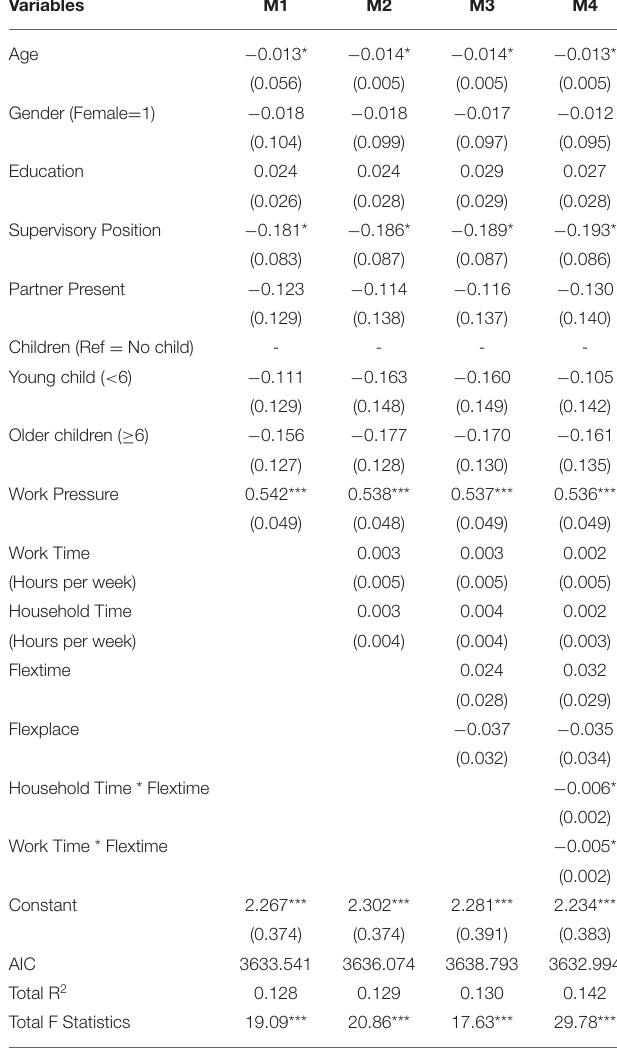
TABLE 1 | Descriptive statistics for variables used ( N = 1,058). TABLE 2 | Unstandardized coefficient estimates for OLS regression predicting burnout ( N = 1,058).